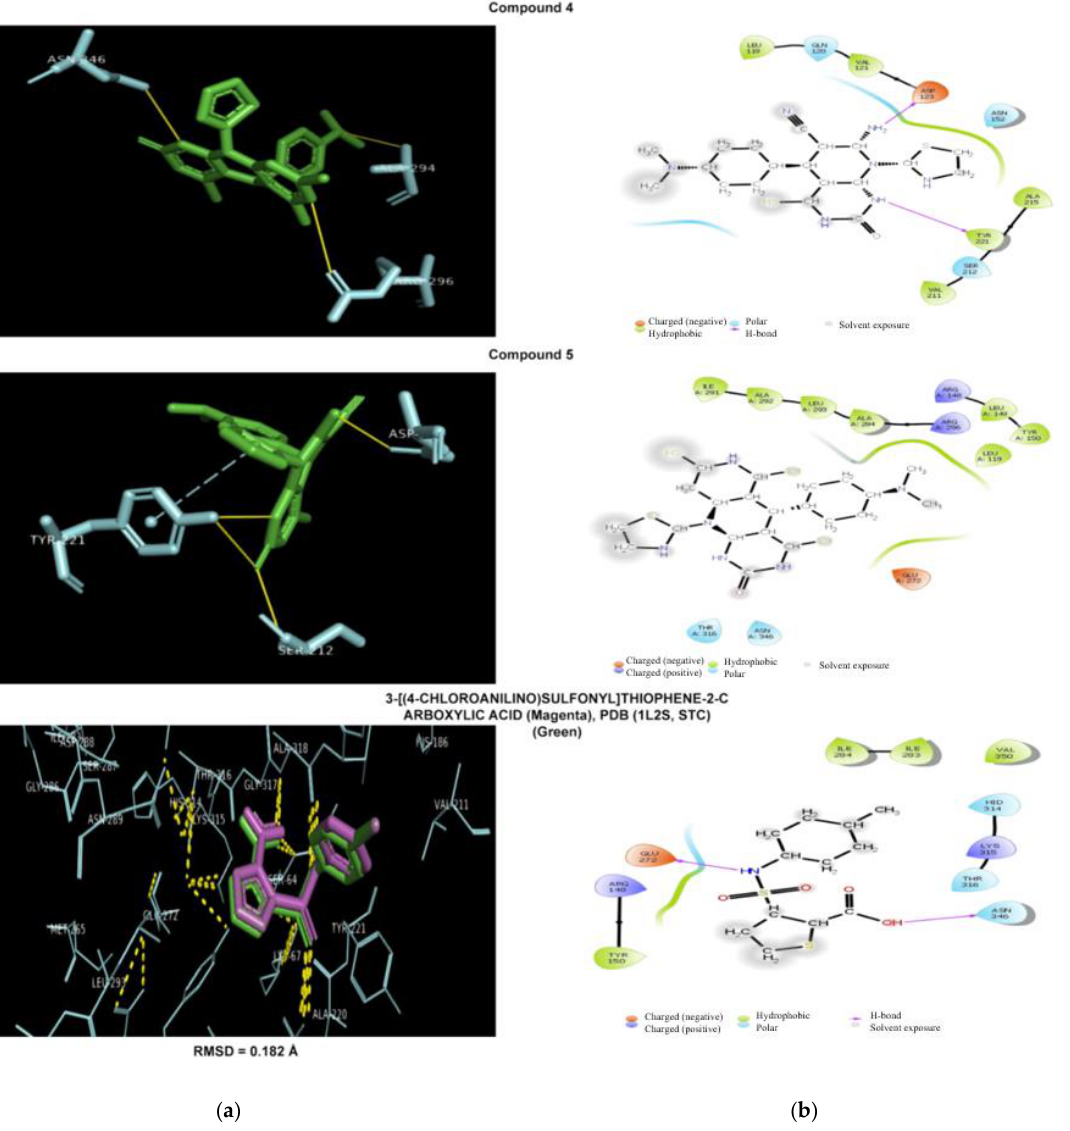
Figure 6. The binding states ( a ) is showing hydrogen bonds residues coloredin cyan and 2D interaction diagrams ( b ) for the compounds 4 , 5 and the native ligand (3-[(4-chloroanilino) sulfonyl] thiophene-2-carboxylic acid) in co-crystalized state ligand (green) and docked state (magenta) against β-lactamase (AMPC) from PDB (1L2S). Table 5. AutodockVina’s flexible docking scores for docking runs of synthesized compounds 4 and 5 and native against each of the three targets AMPC, CYP51 and DPP-IV.